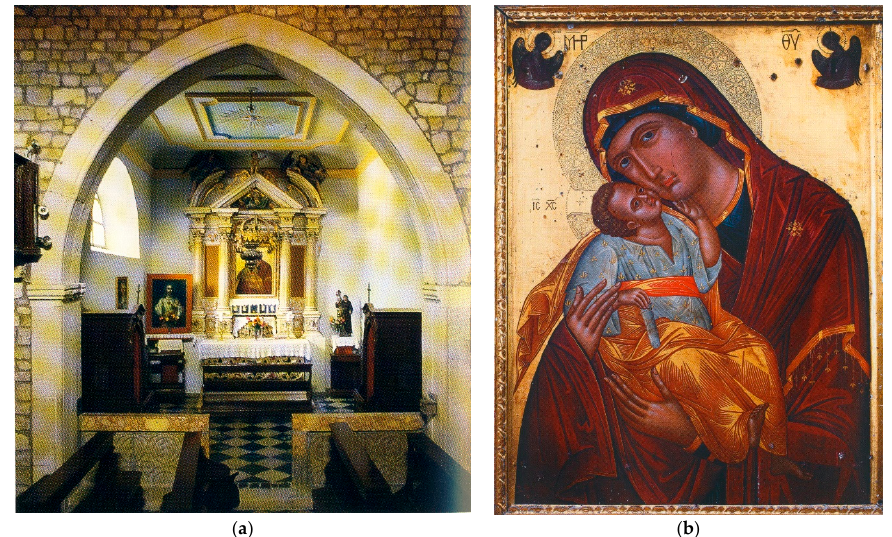
Figure 16. ( a , b ) The icon of the Virgin Galaktotrophousa in the funerary chapel of Andrea Cimalarca , Rab,